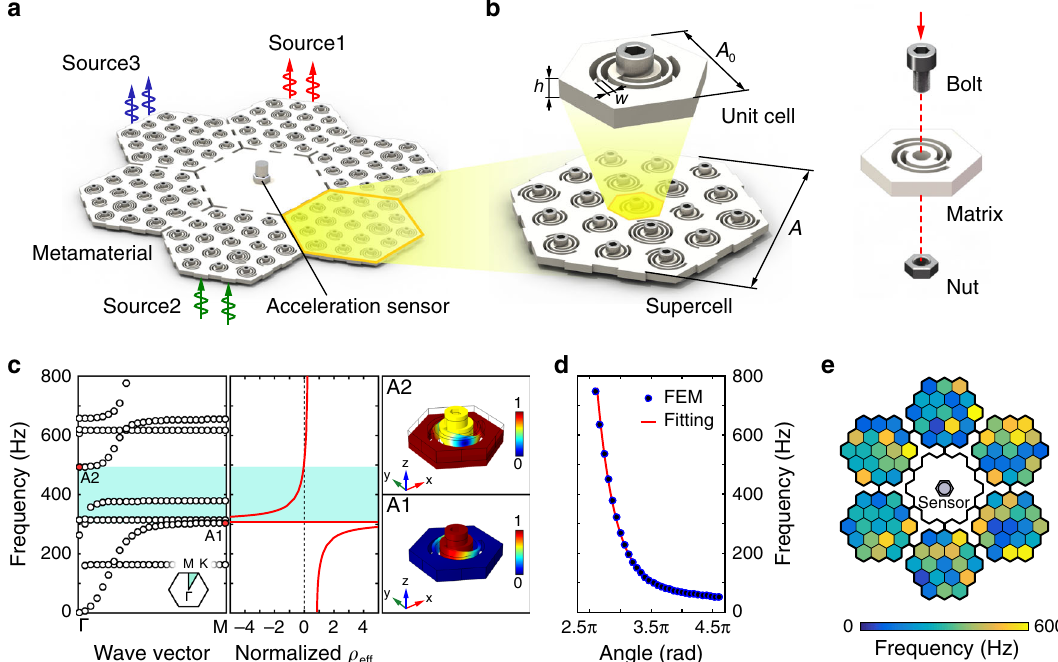
Fig. 2 Randomized resonant metamaterial system for multi-source vibration identi fi cation. a Schematic of the randomized resonant metamaterial system. b The supercell composed of 19 unit cells with different geometric parameters of spiral beams. ( c ) The dispersion curves of the unit cell with θ = 2.952 π . The out-of-plane band gap is from 304.0 Hz to 493.7 Hz. The frequency range of the negative effective mass density is consistent with the out-of- plane band gap. The vibration modes at edges of the band gap are marked by A1 and A2. d The relationship between the local resonance frequency and the angle θ . The results calculated by the fi nite element method (FEM) are marked by circles, and the fi tting curve is marked by the red solid line. e Spatial distribution of local resonance frequencies of the entire